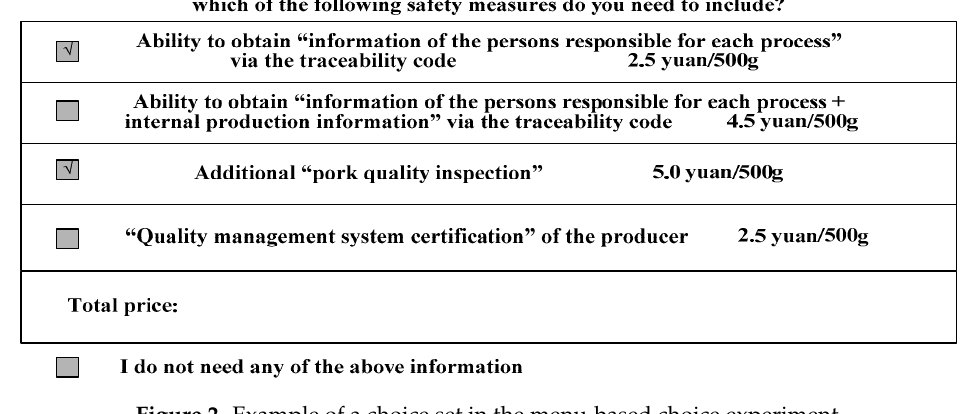
Figure 2. Example of a choice set in the menu-based choice experiment.